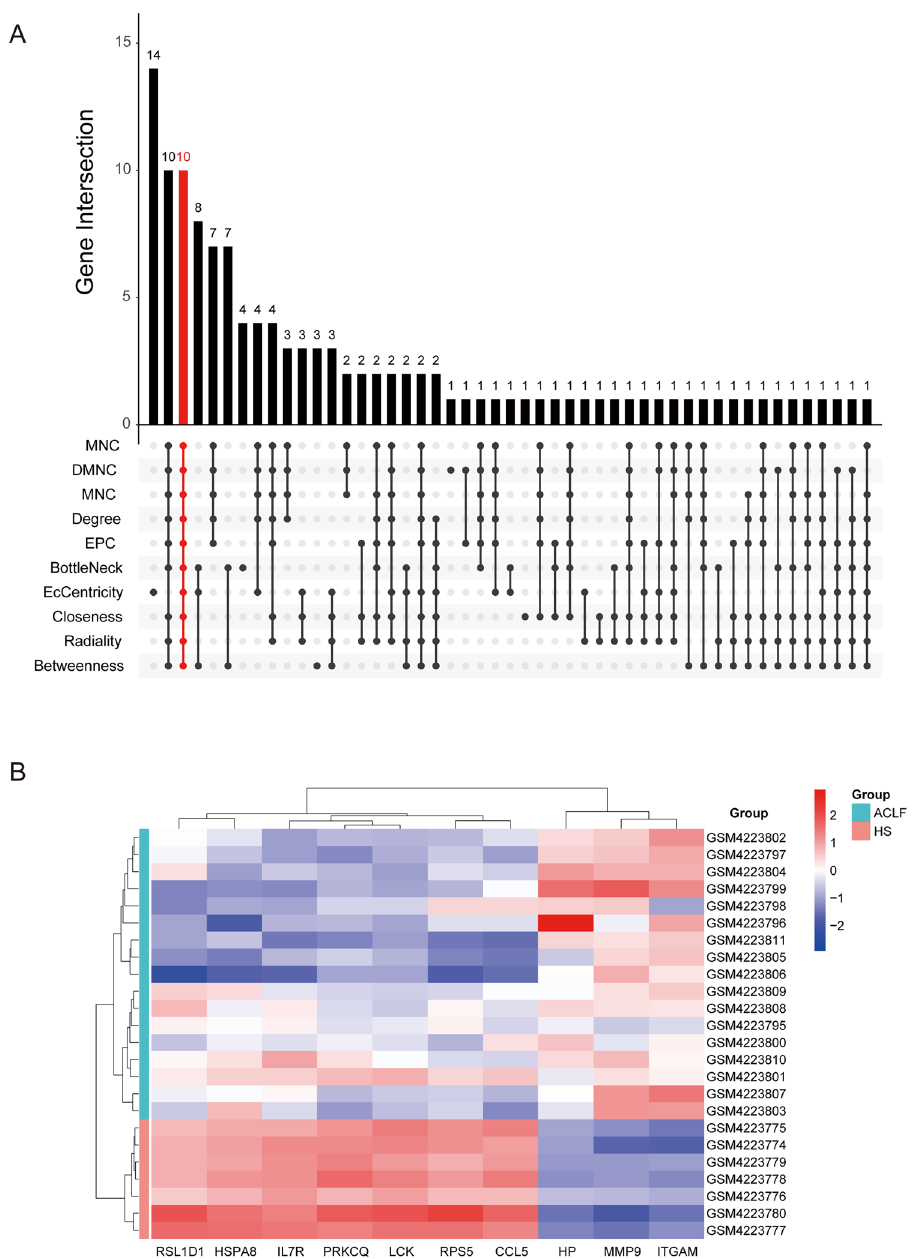
Figure 11. Identification of hub genes. ( A ) The hub genes were screened using 10 topological analysis methods. ( B ) The expression of 10 hub genes in GSE142255 is presented in a